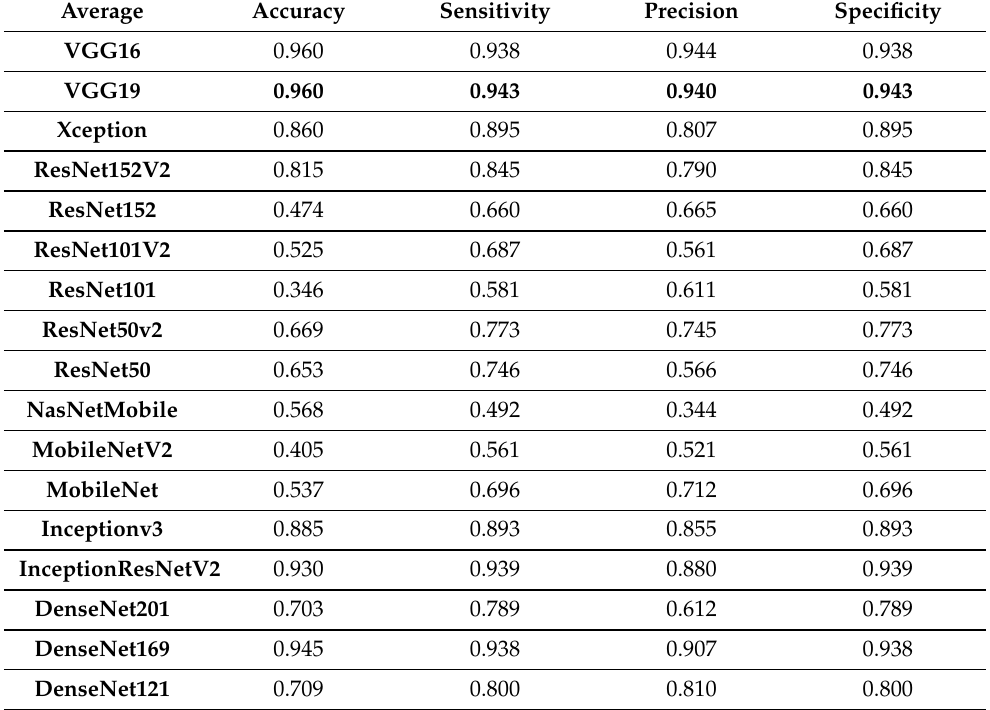
Table 5. Average metric results related to SNR ≥ 0 dataset.